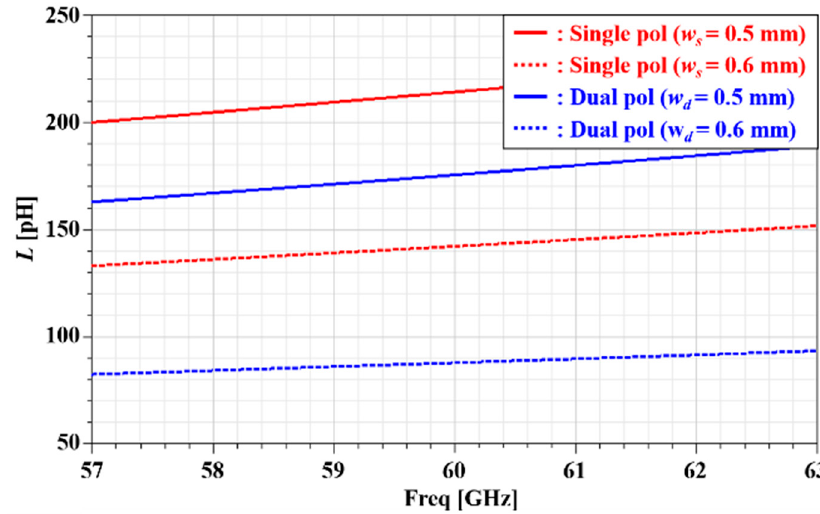
Figure 4. Simulated inductance of dual-pol grid and single-pol grid.